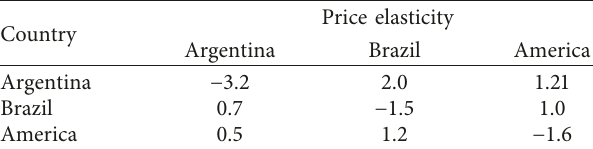
Table 3: The price elasticity of China’s demand for imported soybeans from different